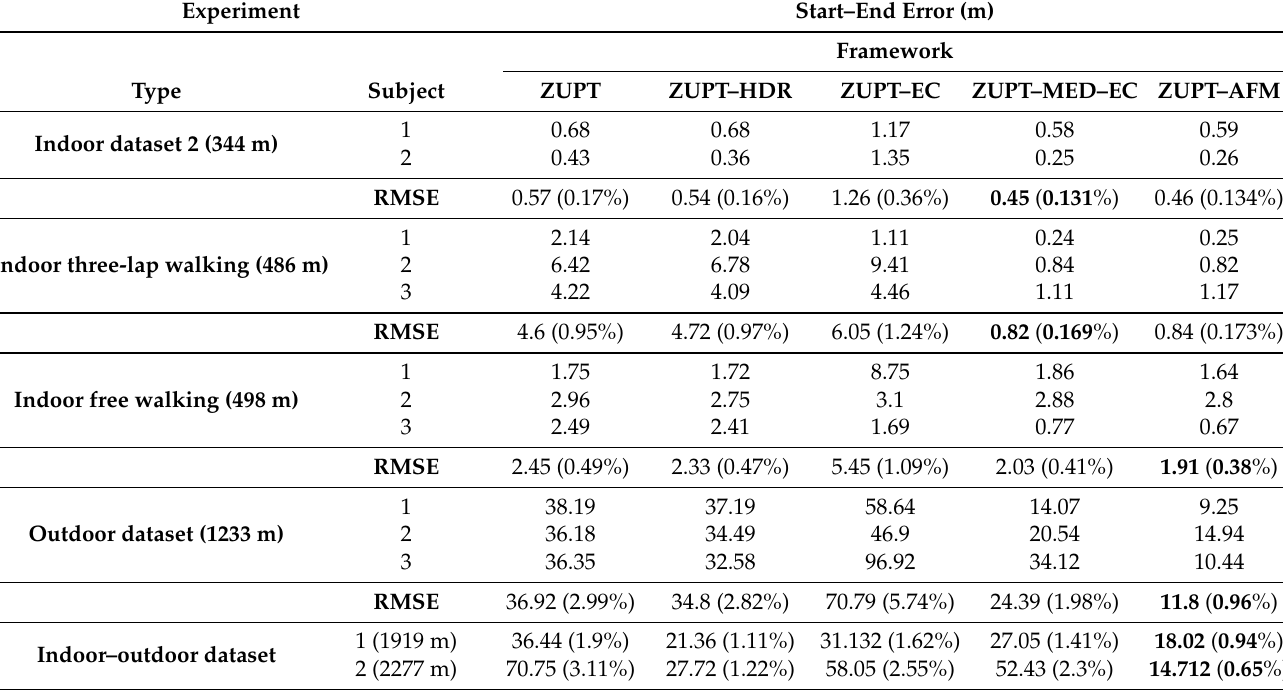
Table 6. Performance of the different frameworks on the medium-scale and large-scale datasets. Each bold number refers to the optimal performance in each